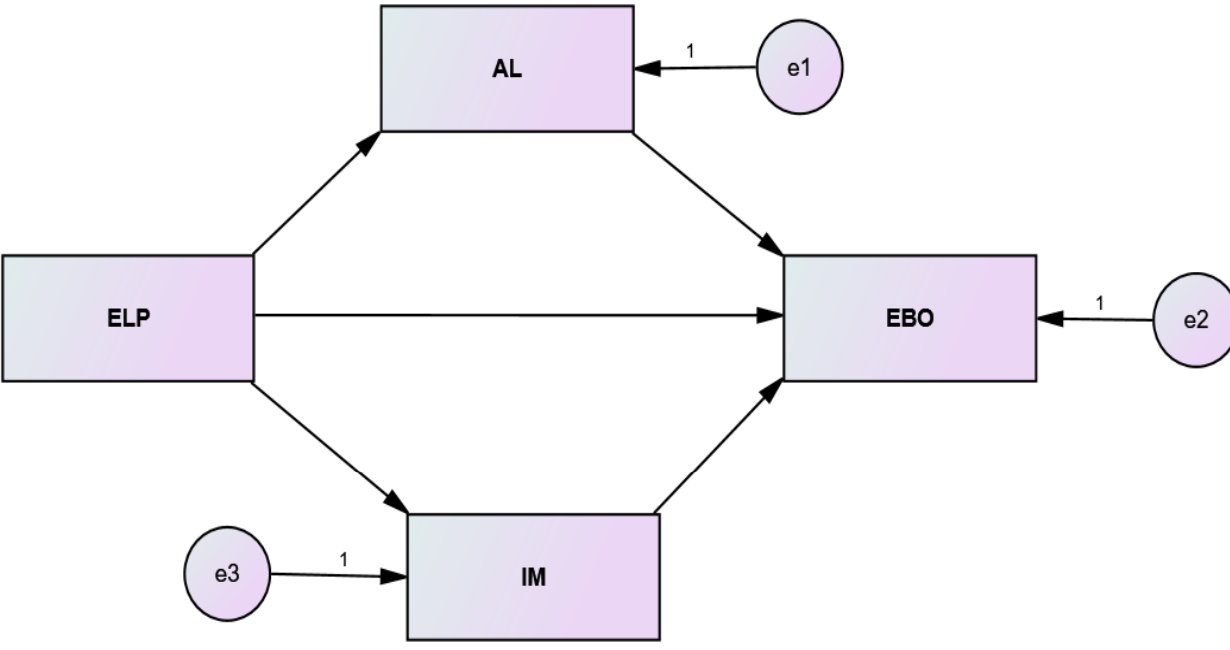
Figure 1. The hypothesized structural